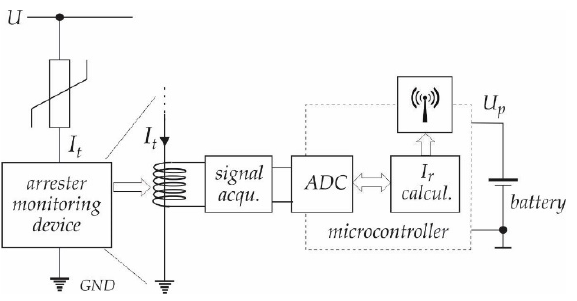
Figure 7. The block scheme of Surge Arrester Monitoring Device (SAMD).